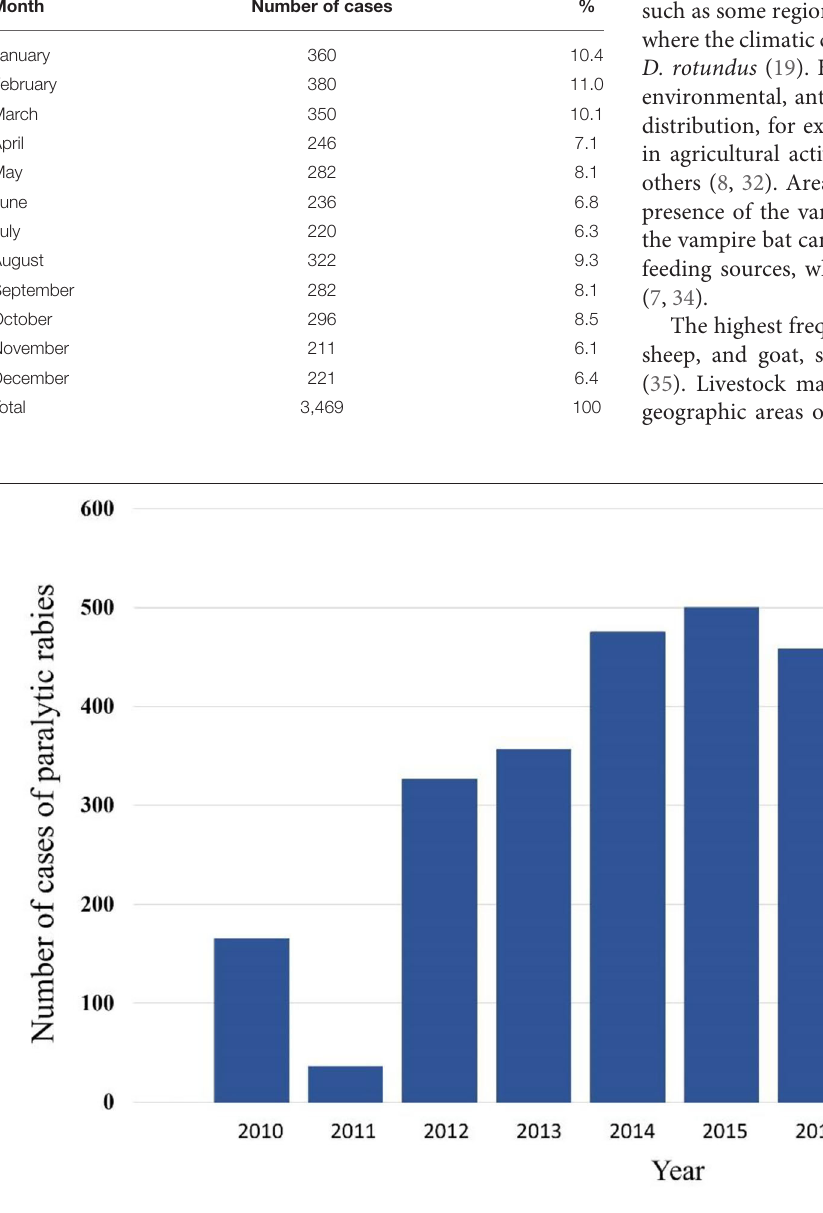
FIGURE 1 | Distribution of cases of rabies in different animal species in Mexico per year, 2010–2019.